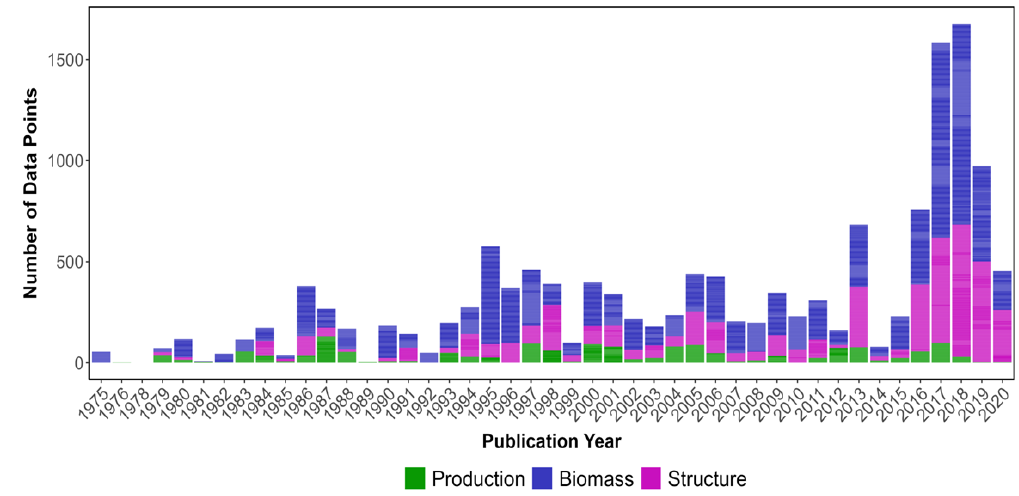
Figure 2. Number of publications that included seagrass data (coloured by type: biomass, structure and production) based on the year of data collection. Data from peer-reviewed publications that did not report the year of sampling were not included in this